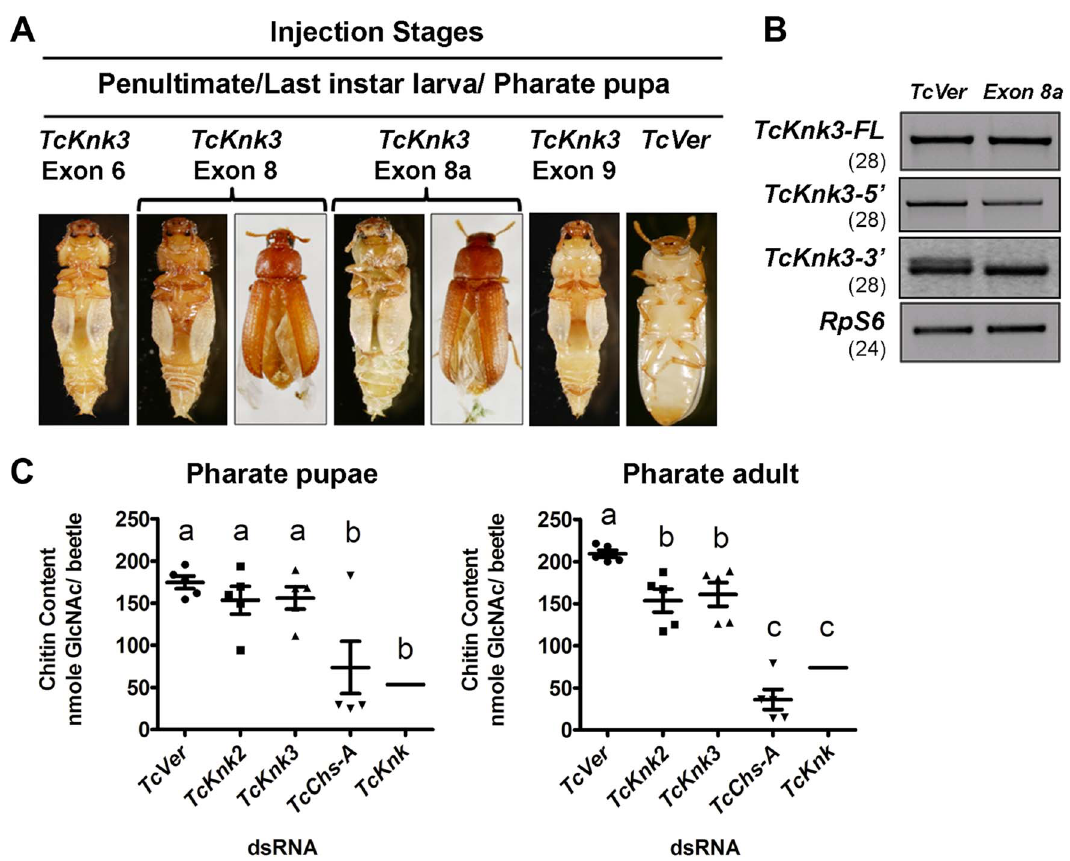
Figure 7. Effect of TcKnk3 dsRNA-treatment on the development of T.castaneum . (A) dsRNAs specific for different exons and intron of TcKnk3 (exon 6, exon 8, exon 9 and exon 8a) were injected into penultimate instar larvae, last instar larvae and pharate pupae. Approximately 60– 100% of the dsRNA-treated insects showed lethal phenotype at pupal-adult molt. Exon 8 and exon 8a dsRNA-treatment led to a weaker phenotype with split elytra. (B) Specific down-regulation of TcKnk3-3 9 transcripts by RNAi. dsRNA (200 ng per insect n=60) for TcKnk3-3 9 (corresponding to exon 8a) was injected into pharate pupae. Five days after injection, total RNA was extracted from pharate adult insects (n=3) and used for cDNA synthesis. Depletion of different transcripts was checked by using pairs of transcript-specific primers (Table S1). For detection of transcripts with or without exon 8a, a pair of forward and reverse primers flanking exon 8a was used (see Table S1). TcRPS6 was used as internal loading control. TcVer dsRNA was injected as a control. RT-PCR for the TcRpS6 transcripts was carried our prior to these analyses to ensure that equal amounts of cDNA templates from different developmental stages were being used in these comparisons. Results are from 28, 28, 28 and 24 cycles of RT-PCR for TcKnk3-FL TcKnk3 - 5 9 and TcKnk3-3 9 and TcRpS6 , respectively. The RT-PCR products were run on separate gels for each RT-PCR product (with different sizes for each transcript), but the figure as shown is composite showing the relevant regions only to avoid ‘‘white space’’. The grainy quality of the amplification products for TcKnk3-3 9 relative to the other RT-PCR products is due to different camera settings used to reveal the minor band from the alternatively spliced product with exon 8a sequences. (C) TcKnk2 or TcKnk3 (exon-9)-specific dsRNA was injected into last instar larvae and pharate pupae. Four to five days after injections, pharate pupal and pharate adult (n=5) insects were collected for chitin content analysis by a modified Morgan–Elson method as described earlier [21]. dsRNA for TcVer and TcChs-A were injected as negative and positive controls, respectively. The mean chitin content for TcKnk dsRNA treated insects is adapted from previously published data